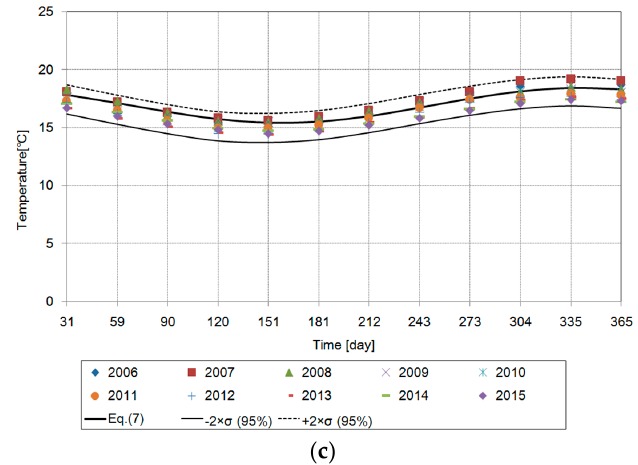
Figure 5. Comparison of experimental and predicted ground temperature distribution in Pohang, Korea: ( a ) depth of 1 m; ( b ) depth of 3 m; ( c ) depth of 5 m.